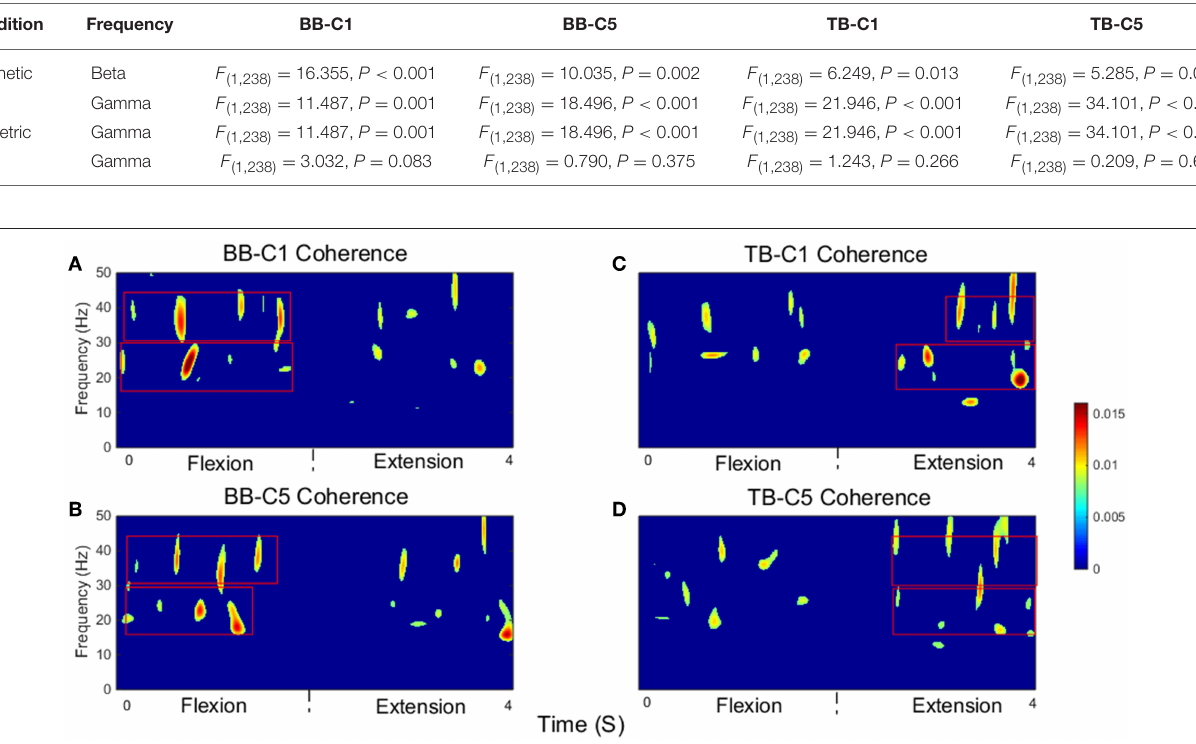
FIGURE 6 | Group average of significant CMC between EEG signal from C1 and C5 and EMG signal from the BB and TB muscles during isokinetic movement. (A,B) show SCV for BB-C1 and BB-C5 coherence, (C,D) show SCV for TB-C1 and TB-C5 coherence, respectively. Note that red box areas indicate that BB and TB muscles acted as agonist, in beta and gamma bands, respectively. The first 2s are elbow flexion stage and the last 2s are elbow extension stage. Confidence level was 95%.